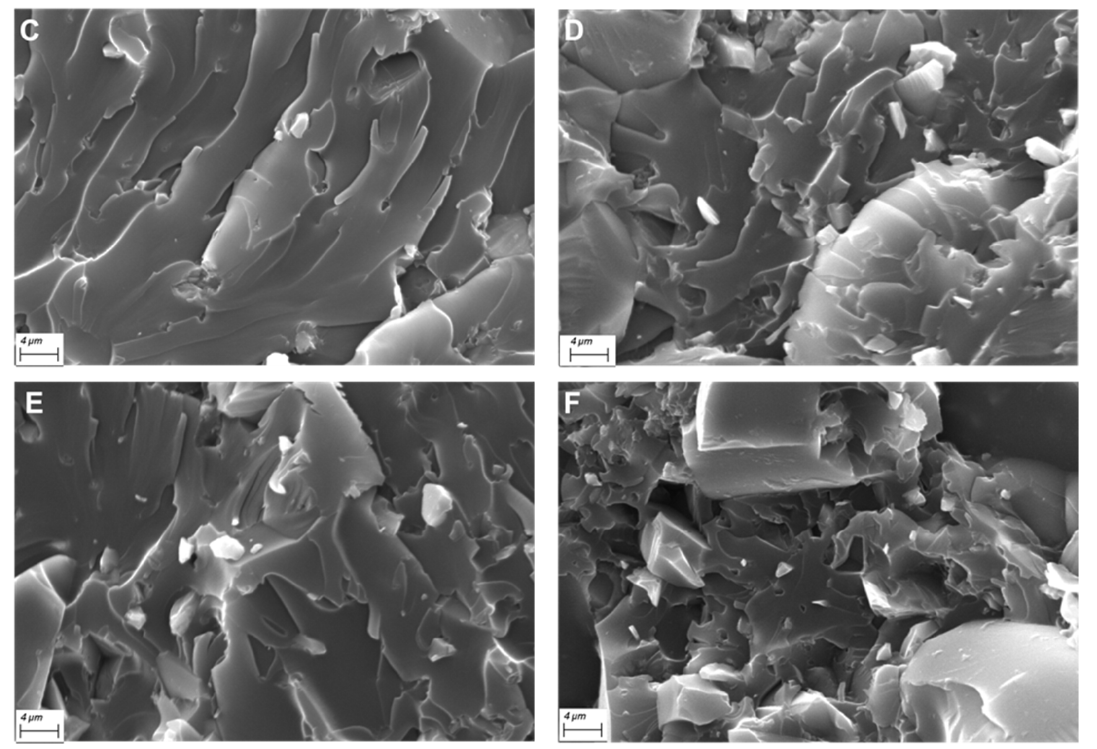
Figure 3. Typical SEM micrographs (at 5000×) of UV-LED cured films: Eb150 ( A ), Eb150 + 10%G ( B ),